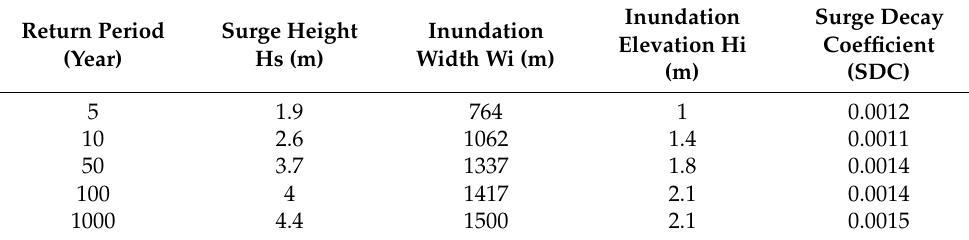
Table 1. Storm surge height, inundation width, end inundation elevation, and surge decay coefficient for different return